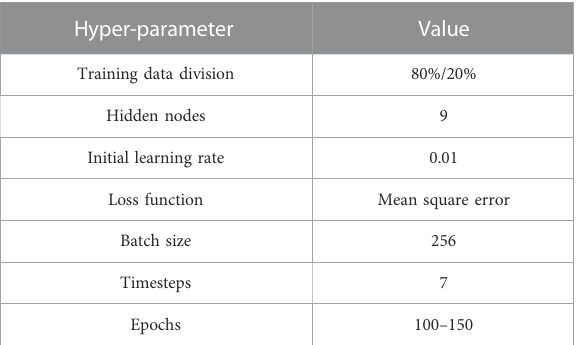
TABLE 1 Hyper-parameters of the LSTM-RN